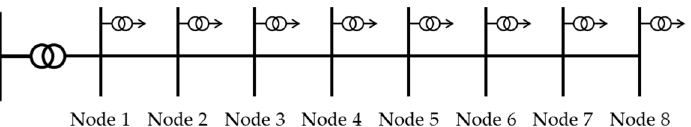
Figure 6. Medium voltage electric network topology.